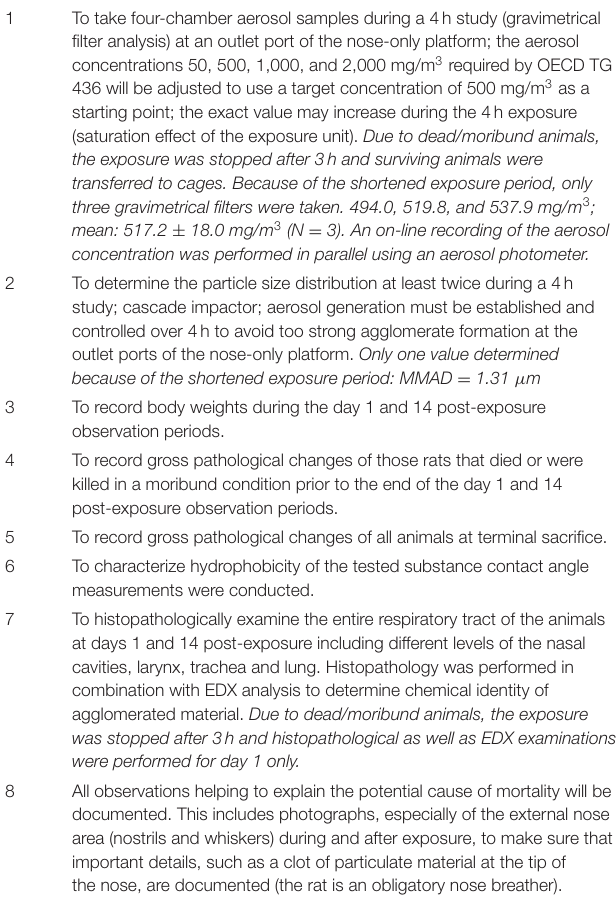
TABLE 1 | Extended experimental design of the acute inhalation